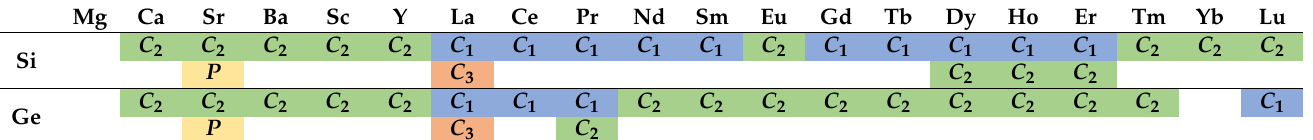
Table 1. Overview of structure types of known binary monosilicides and –germanides with alkaline and rare earth elements comprising infinite chains ( C 1 —( oP 8)FeB, C 2 —( oS 8)CrB, C 3 —( oS 16)LT-LaSi) or isolated polyanions ( P —( oI 40)SrSi). Availability of full structure refinement data indicated by blue letters